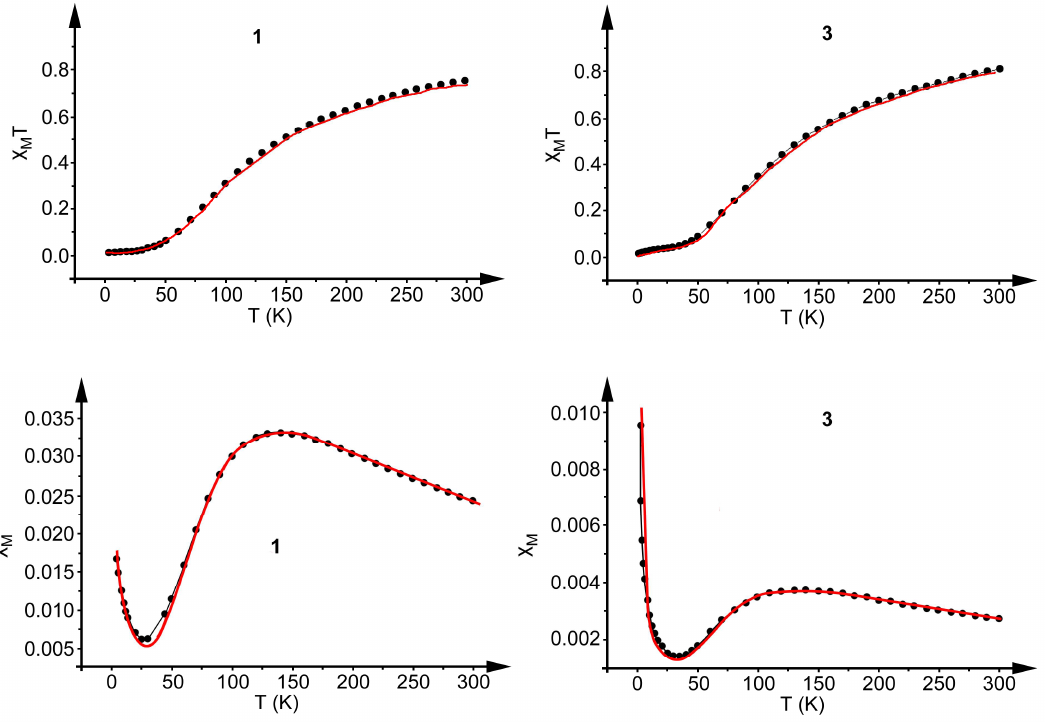
Figure 5. ( Top ) Temperature dependence of χ M T (cm 3 mol − 1 K) of a solid sample of compounds 1 and 3 . ( Bottom ) Temperature dependence of χ M (cm 3 mol − 1 ) of a solid sample of compounds 1 and 3 . The solid red lines represent the best fit. R = ∑ ( χ MTcalc − χ MTobs ) 2 / ∑ ( χ MTobs ) 2 inferior to 1.0 × 10 − 4 .